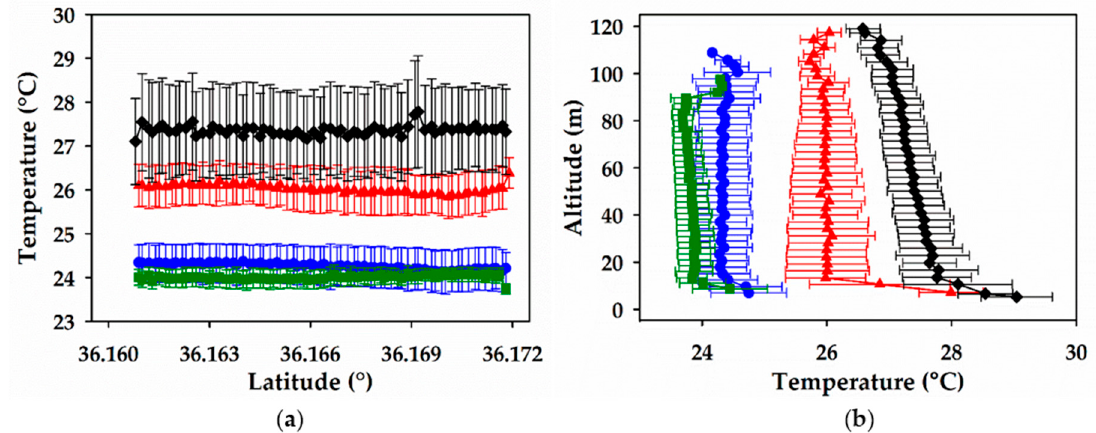
Figure 5. ( a ) The horizontal and ( b ) the vertical flight paths measuring temperature variations during the morning of 28 June, 2017 for the times (green square) 6:04–6:56 am (UTC–5 h), (blue circle) 7:06–7:57 am (UTC–5 h), (red triangle) 8:11–9:05 am (UTC–5 h), and (black diamond) 9:28–10:22 am (UTC–5 h).